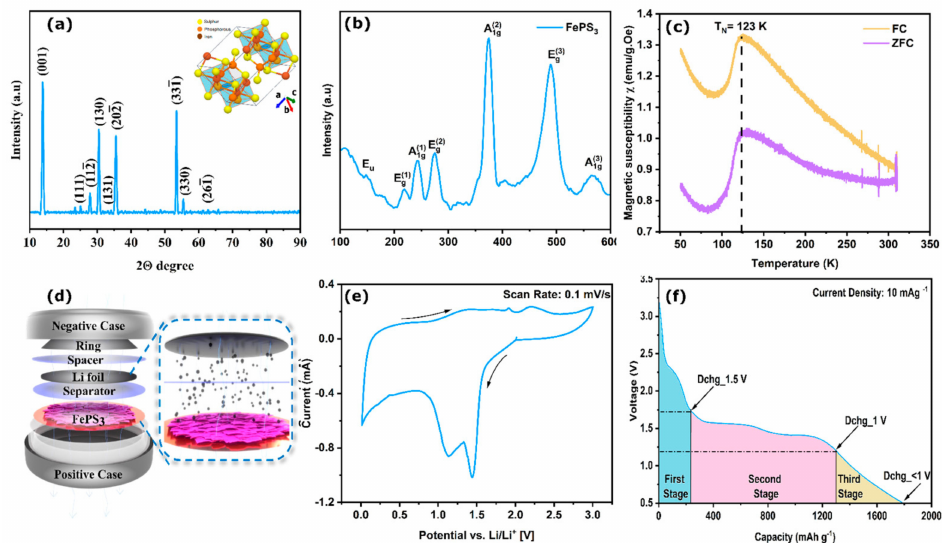
Figure 2. ( a ) X-ray diffraction pattern, (inset: geometric model of FePS 3 molecule with octahedral voids), ( b ) Raman characterization, and ( c ) vibrating sample magnetometer (VSM) analysis of as- synthesized FePS 3 . χ vs. T plot for pristine FePS 3 in the temperature range of 50–300 K under an applied magnetic field of H = 100 Oe. FC and ZCF represent field cooling and zero field cooling, represented by blue and green solid lines. ( d ) Schematic representation of lithium primary battery with FePS 3 nanoflakes as cathode. ( e ) CV plots at 0.1 mV s − 1 . ( f ) Galvanostatic full-discharge profile of FePS 3 cathode with proposed three-stage